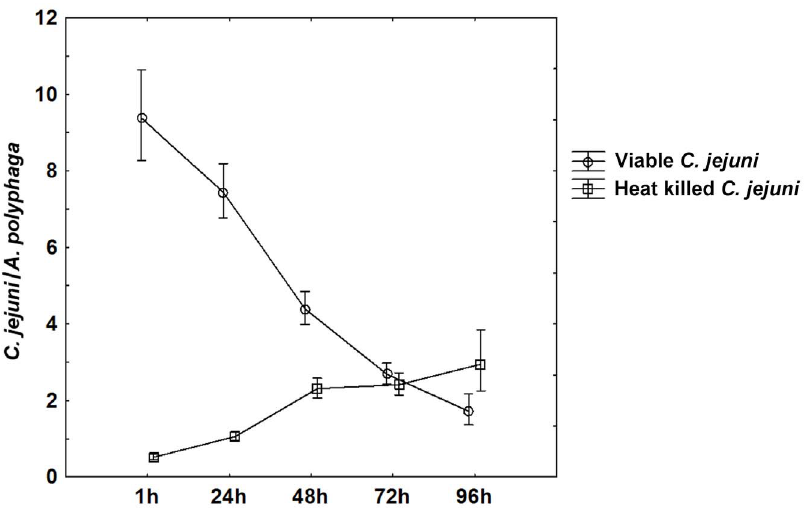
Figure 1. Adhered/internalized viable and heat killed C.jejuni per A.polyphaga trophozoite. After 1 h of co-incubation the majority of amoeba associated viable C. jejuni were found on the surface of trophozoites but at 24 h and thereafter, the majority were found in intracellular vacuoles. The number of viable bacteria internalized into A. polyphaga trophozoites was significantly higher than for heat killed bacteria during the first 48 h. Data are based on three to five independent experiments for samples taken at 1 h–72 h and on one experiment for 96 h. Mean 6 95 confidence interval.